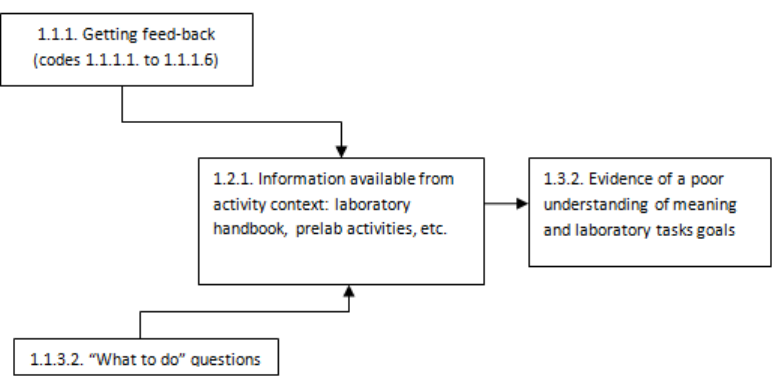
Fig. 3. Set of codes with the stronger linkage and quantitative relevance in our educational